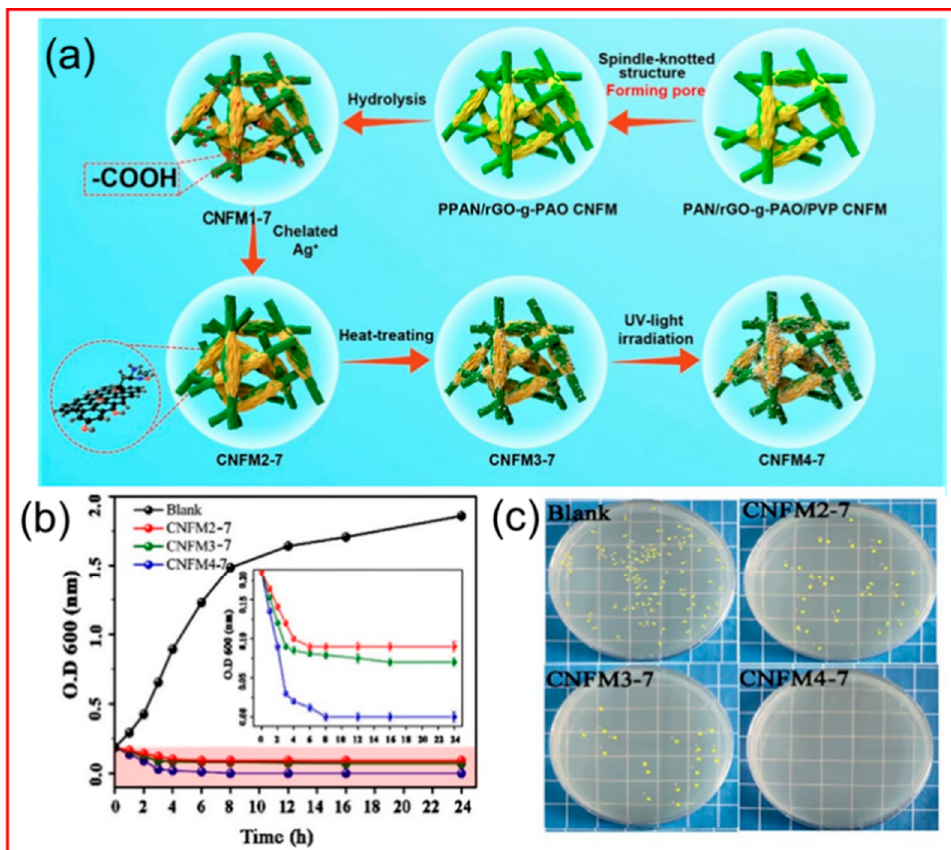
Figure 13. ( a ) Schematic of the preparation of P − PAN/rGO − g − PAO@Ag+/Ag CNFM; ( b ) growth of E. coli on CNFMs; inset: magnified view of the red area; ( c ) incubation in solid medium containing CNFM2 − 7, CNFM3 − 7 and CNFM4 − 7 and blank at 37±1°c for 24h to observe E. coli colony formation situation [162].